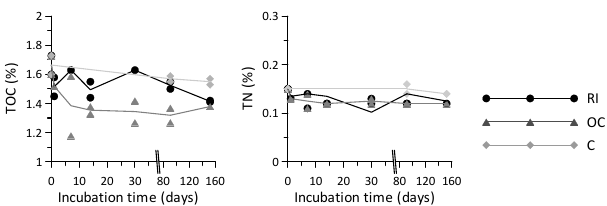
Figure 3. Total organic carbon (TOC) and total nitrogen (TN) con- centrations in a sandy loam soil from the Rakaia River catchment, New Zealand, during incubation ( t = 152 days) in river (RI), ocean (OC), and distilled (C) water.